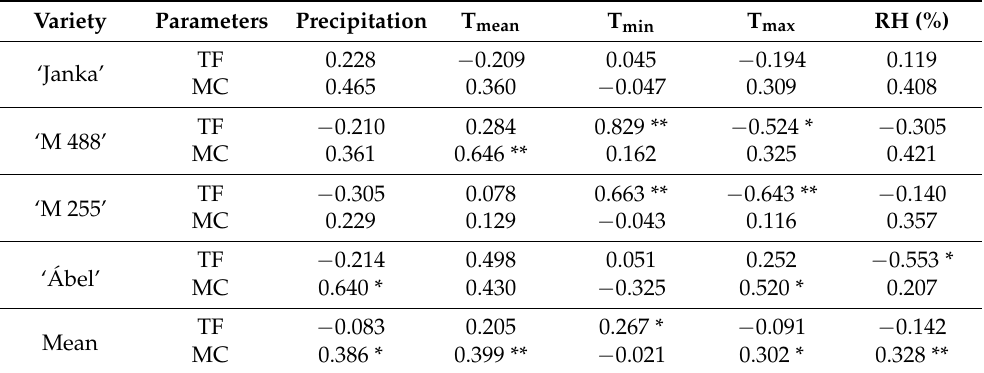
Table 3. The correlation matrix among the meteorological parameters, moisture content (MC), and threshing force (TF). The mean indicates the average of the four varieties. * or ** means that correlation is significant at the 0.05 or 0.01 level